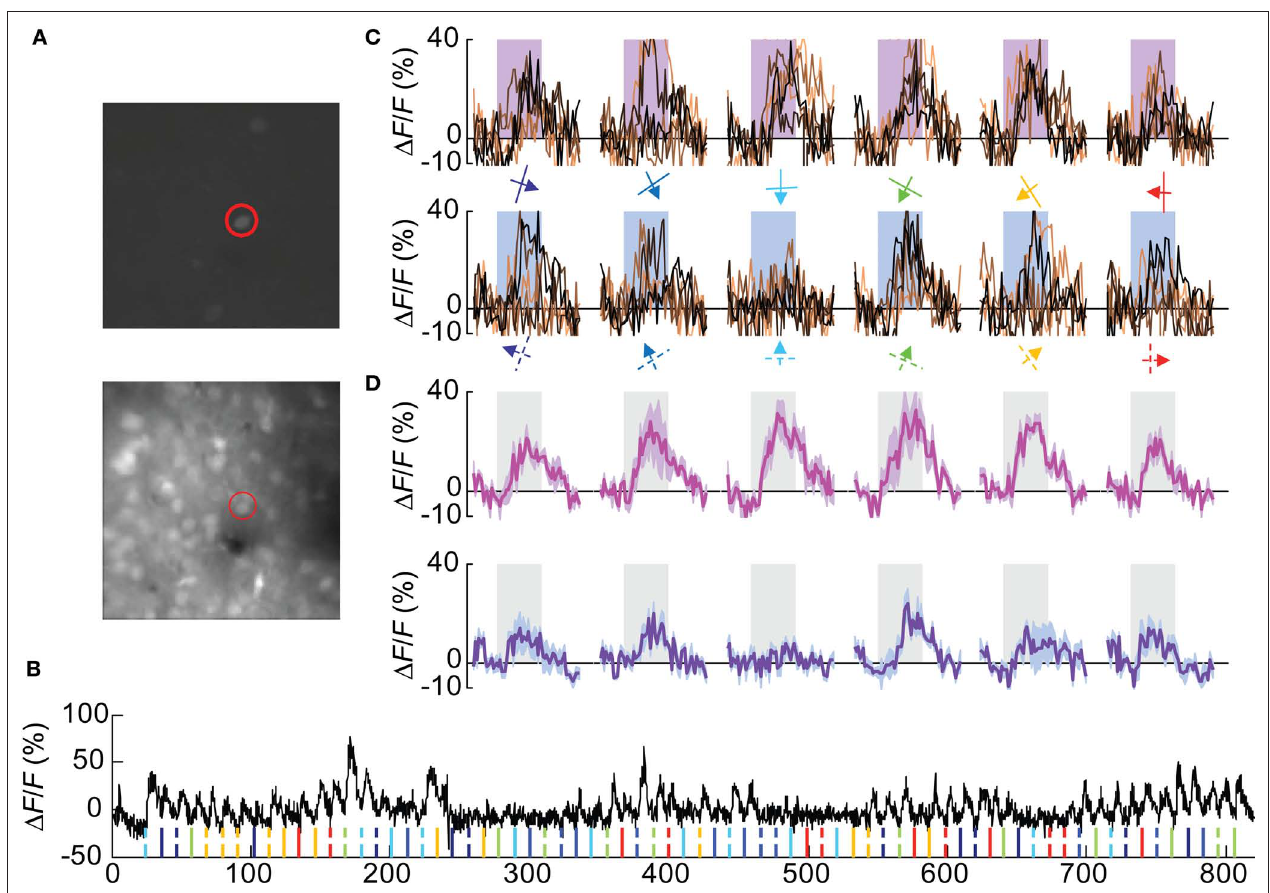
direction [see also (C) lower row]. (C) Plots in the upper row are change in fluorescence ( ∆ F / F ) of the cell to eight presentations of six orientation gratings moving in one direction (shown by colored arrows). Lower row is for opposite direction of motion. Shaded rectangular bar represents time period of stimulus presentation (5 s). (D) Average of eight presentations in (C) (upper row in magenta and lower row in purple). Shaded area around the mean represent mean ± SEM ( n = 8